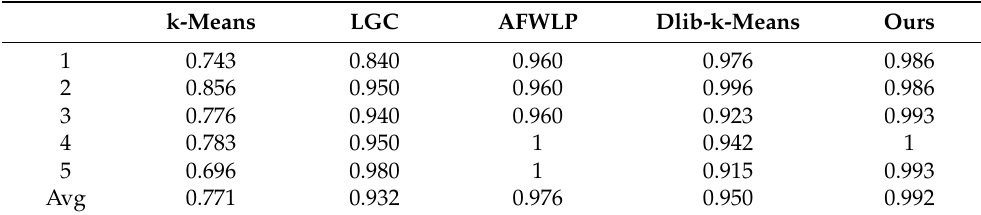
Table 2. Initial parameters of q-learning for